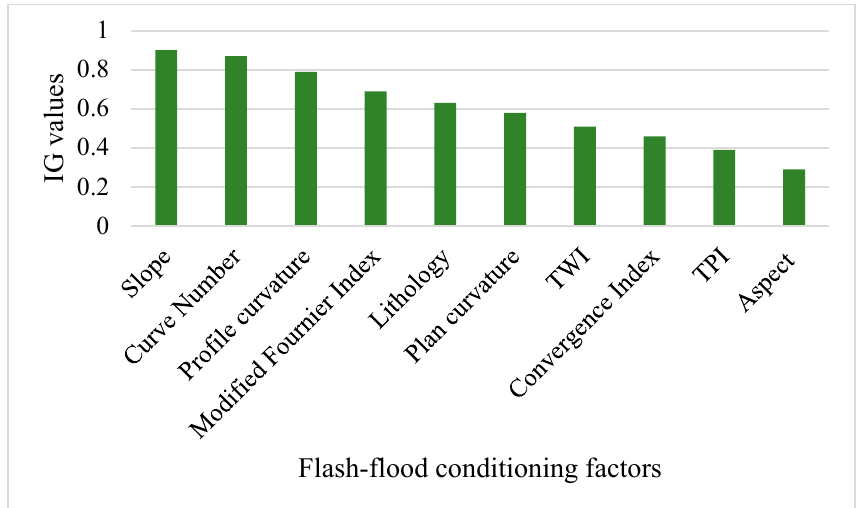
Figure 7. Flash ‐ flood conditioning factors and their predictive ability. Figure 7. Flash-flood conditioning factors and their predictive